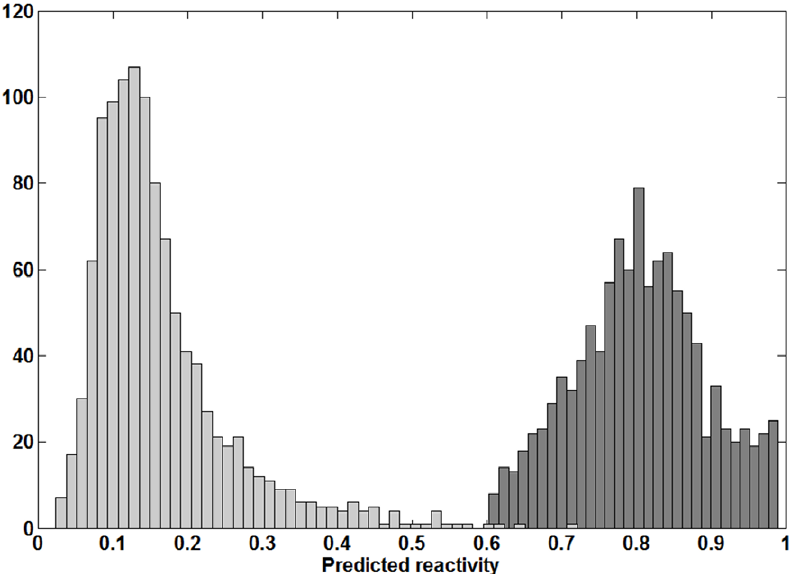
Figure 4. The distributions of the predicted reactivities of bonus round peptides. We selected the same number of peptides (i.e. 1100) both deriving from negative and from positive clusters. The reactivity of the peptides of the two groups is predicted through the final best model proposed for the main challenge. This figure shows the histogram of such predicted reactivities. In particular we considered the binary classes 0- negative (reactivity between 1 and 1000) and 1-positive (reactivity between 10000 and 65536); the predicted reactivity of a peptide in the range [0:1] is given by the probability to belong to the positive class.